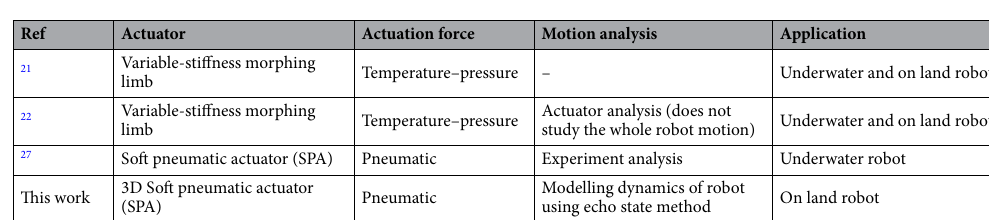
Figure 10. ( a ) Turtle movement actuated by front drive SPA145 and SPA35 modeling by ESN, (a1) Turtle path from tracker software, (a2) XY coordinates of turtle path, smoothed path, and result path from ESN. (a3) Percentage of error in X and Y points. ( b ) Turtle movement actuated by front drive SPA60 and SPA120 modelling by ESN, (b1) Turtle path from tracker software, (b2) XY coordinates of turtle path, smoothed path, and result path from ESN, (b3) Percentage of error in X and Y points.